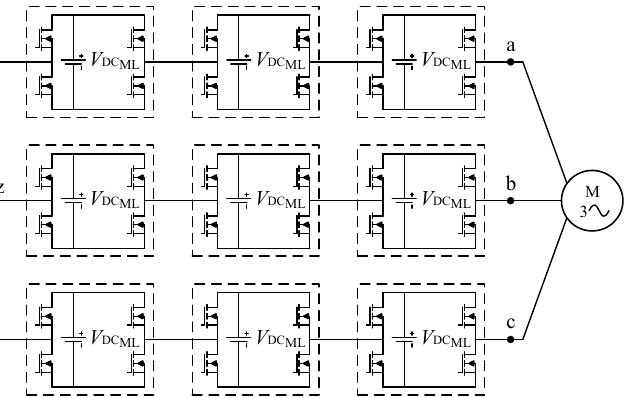
Figure 3. Topology of a seven-level CHB inverter forming a modular battery system used for variable speed drive applications such as vehicle